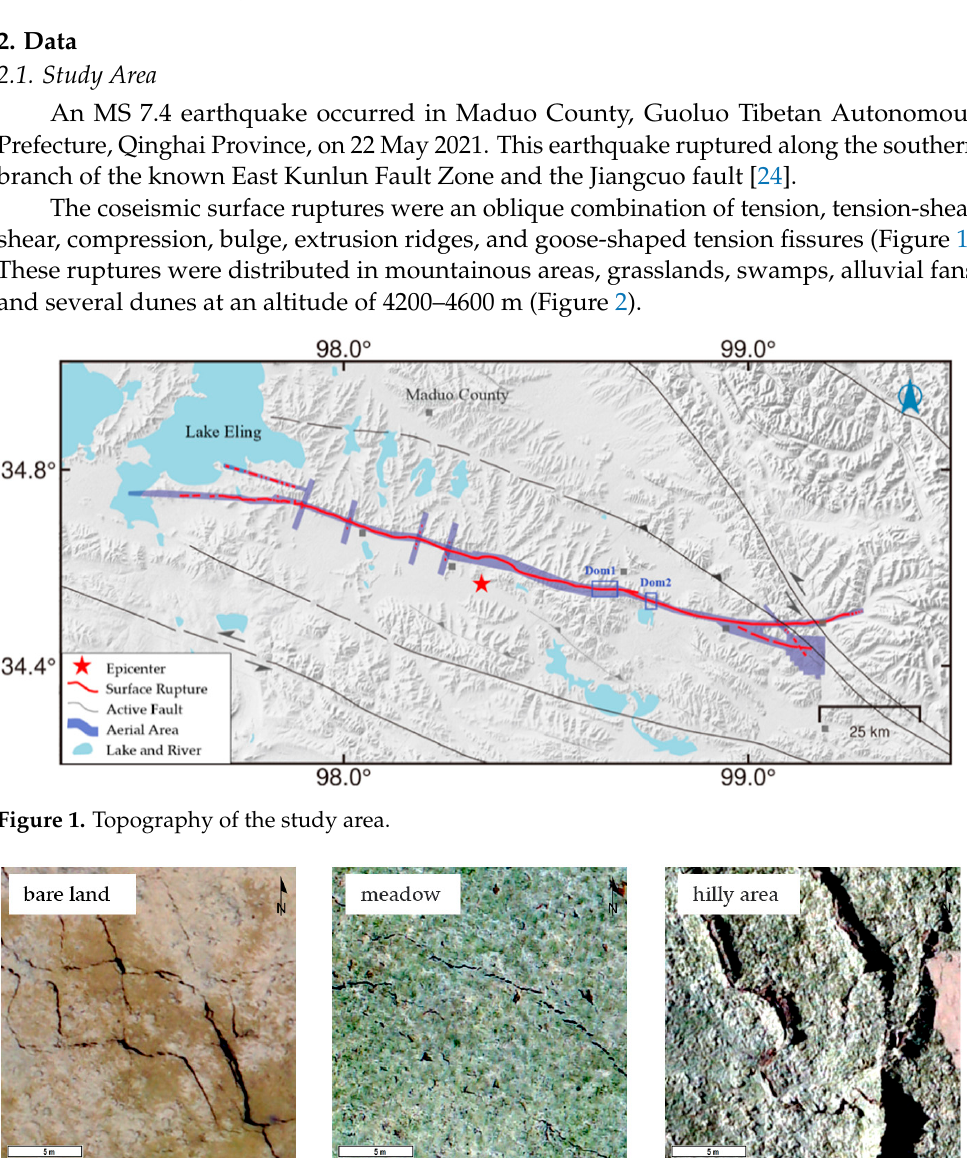
Figure 2. Different forms of coseismic surface ruptures.